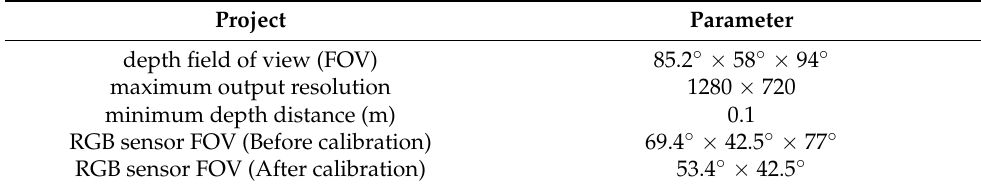
Figure 12. Tangent line at the center line. Where: ( a ) tangent line at end point. ( b ) tangent line at the center point on the line.